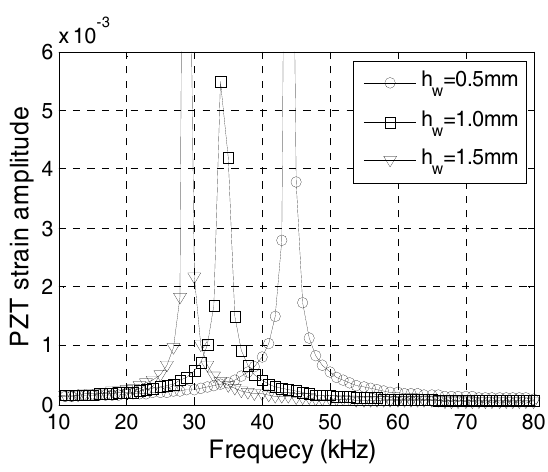
Figure 11. Frequency-strain curve with different waterproof layer thicknesses.